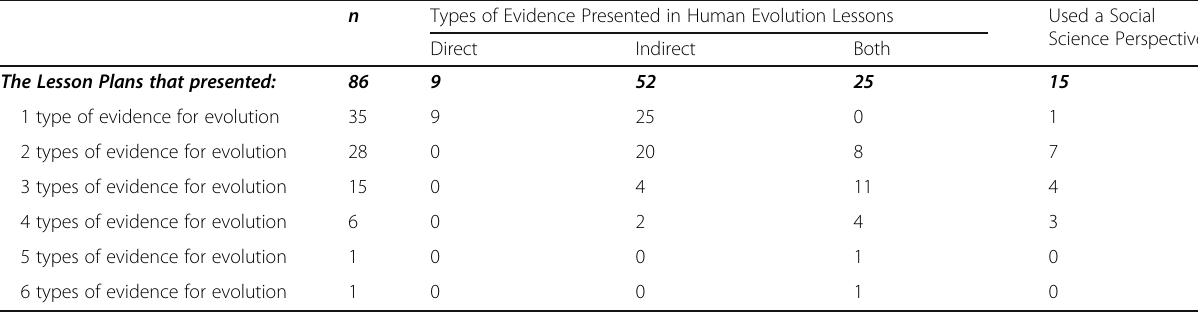
Table 3 Distribution of types of evidence for 86 human evolution lesson plans n Types of Evidence Presented in Human Evolution